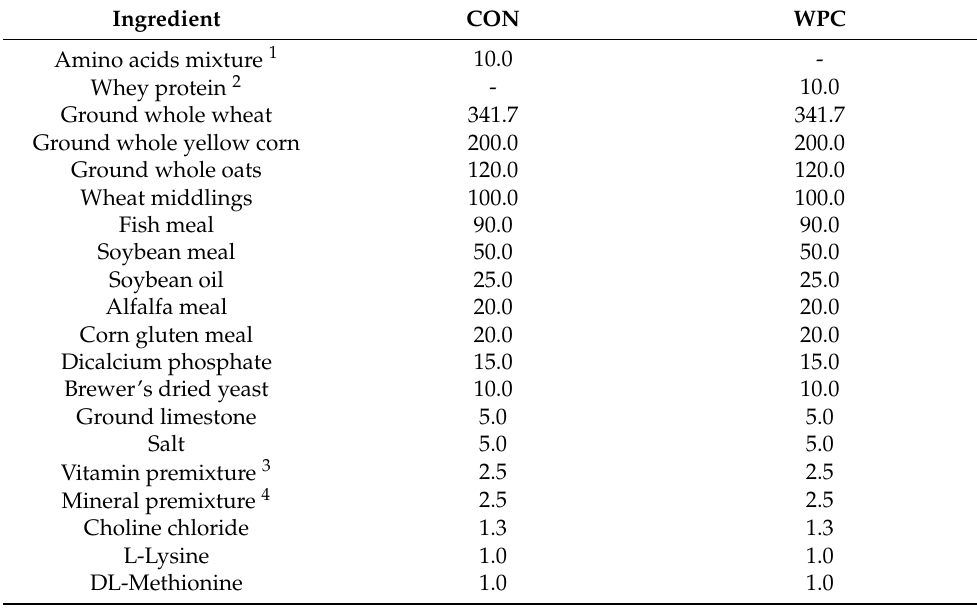
Table 1. Composition of CON and WPC diets in the experiment